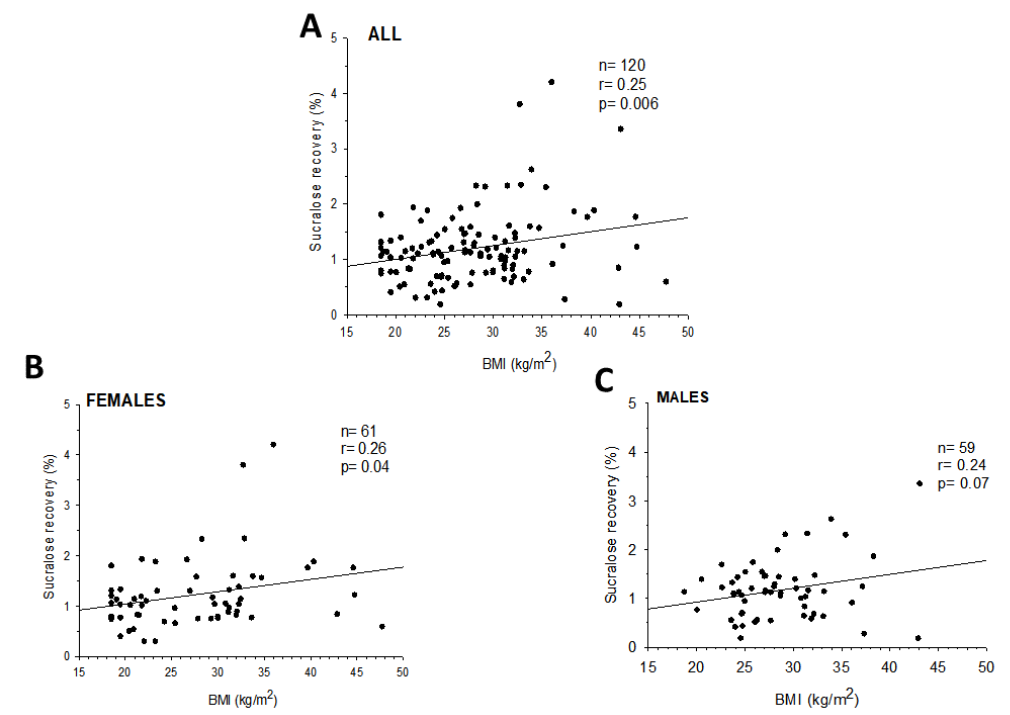
Figure 4. Correlation between sucralose recovery and BMI in all subjects ( A ), females ( B ), and males ( C ).